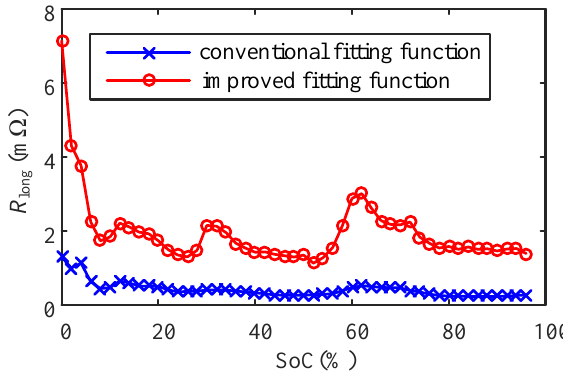
Figure 10. Time constant estimation results with different lengths of the experimental dataset: ( a ) τ short ; ( b ) τ long .